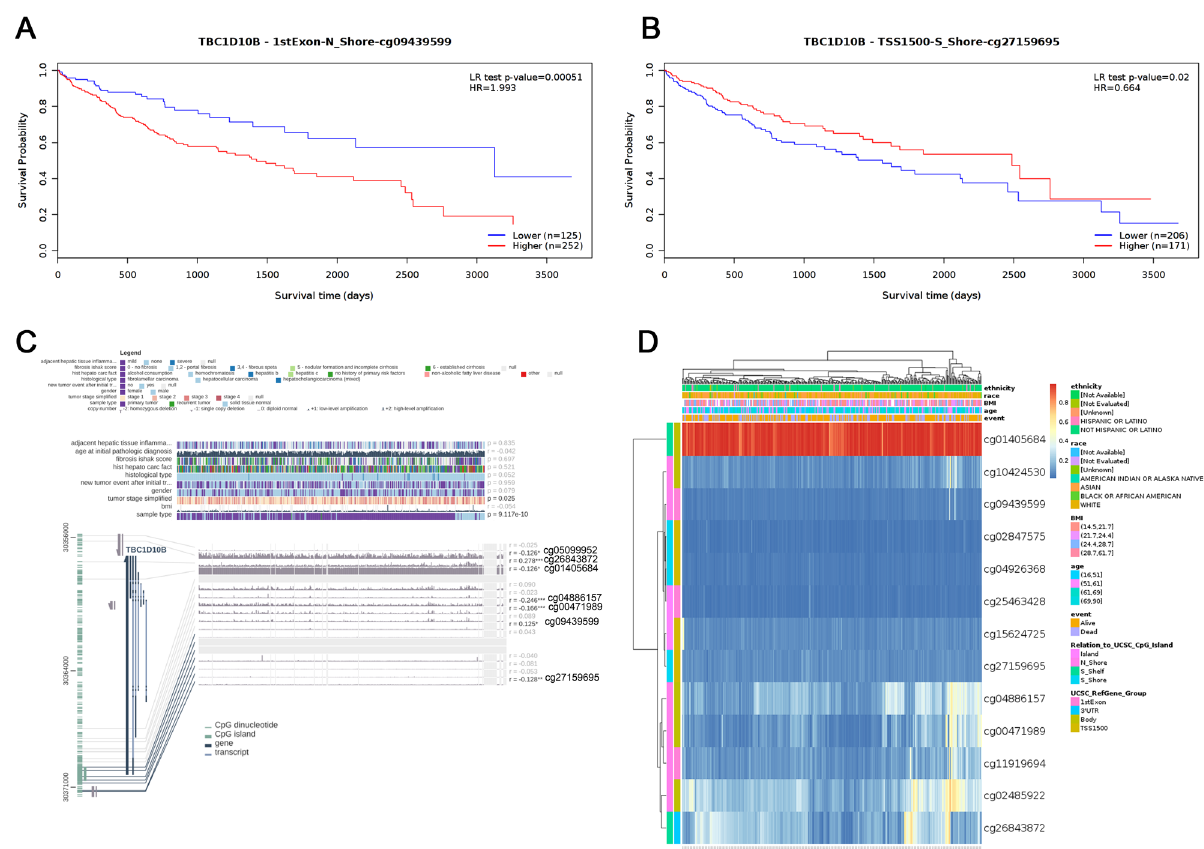
Figure 7. The MethSurv obtained the effect of hypomethylation level and TBC1D10B expression on prognosis in LIHC. ( A,B ) The Kaplan–Meier survival of the DNA methylation of TBC1D10B at cg09439599 and cg27159695 probes. ( C ) Association between SND1 DNA methylation and gene expression for the LIHC. ( D ) The visualization between the methylation level of TBC1D10B in